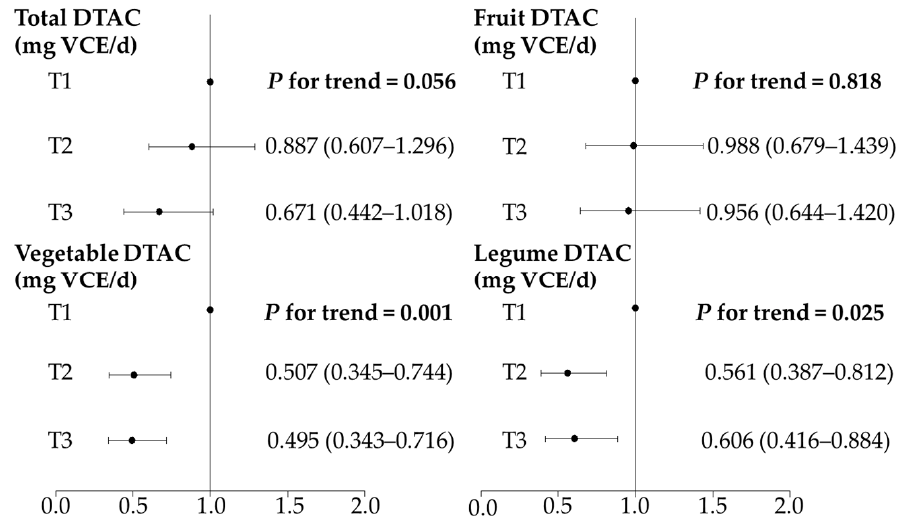
Figure 4. Cox proportional hazards regression analysis of event status in participants with amy- otrophic lateral sclerosis (ALS) according to the tertiles of dietary total antioxidant capacity (DTAC). The adjusted hazard ratio (HR) and 95% confidence interval (CI) were determined by Cox propor- tional hazards regression analysis after adjusting for the age at symptom onset, sex, body mass index, onset site, disease progression rate, and energy intake.